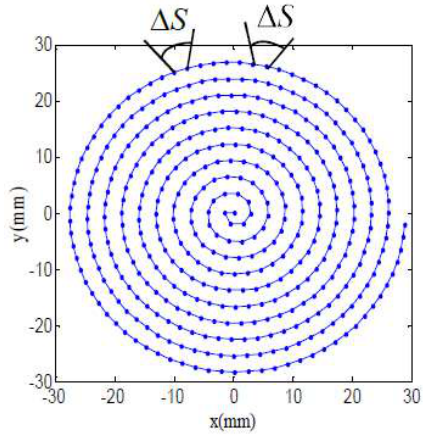
Figure 7. Constant arc-length cutting path.